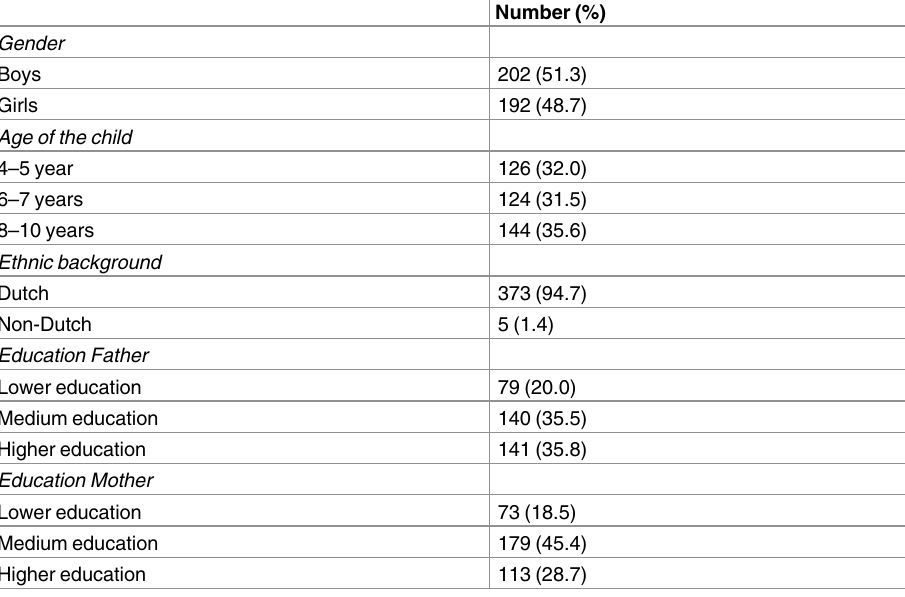
Table 1. Social and demographic background of study population.